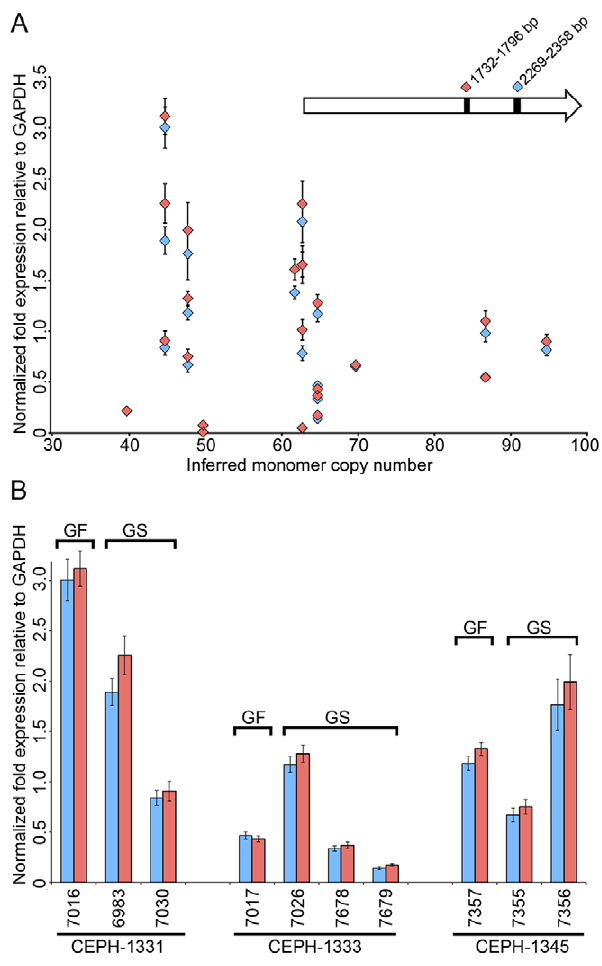
Figure 6. Lack of correlation between array size, expression and inheritance. (A) Graph showing normalized expression levels of DXZ4 relative to GAPDH (y-axis) plotted against the inferred monomer copy number of DXZ4 (x-axis) for 22 different males as determined by PFGE. The right facing arrow represents a single DXZ4 monomer with the location of the regions amplified indicated. The plotted data indicates qRT-PCR for each of the two regions (pink diamond v blue diamond) from triplicate amplifications. (B) Expression levels of DXZ4 in maternal grandfathers (GF) plotted alongside grandsons (GS) who inherited their maternal grandfathers DXZ4 array. Data shown for three independent CEPH families. doi:10.1371/journal.pone.0018969.g006 DXZ4 from their maternal grandfather. As with the size versus